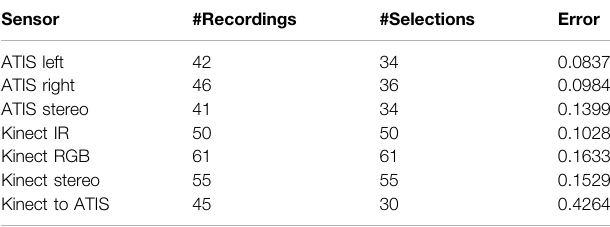
FIGURE 2 | Sensor setup featuring the Kinect mounted on top and two ATIS underneath. All sensors are fi xed on a 3D-printed camera mount. The blue, red and gray cables are connecting the trigger IN/OUT pins required for synchronizing the event-based sensor ’ s individual clocks.